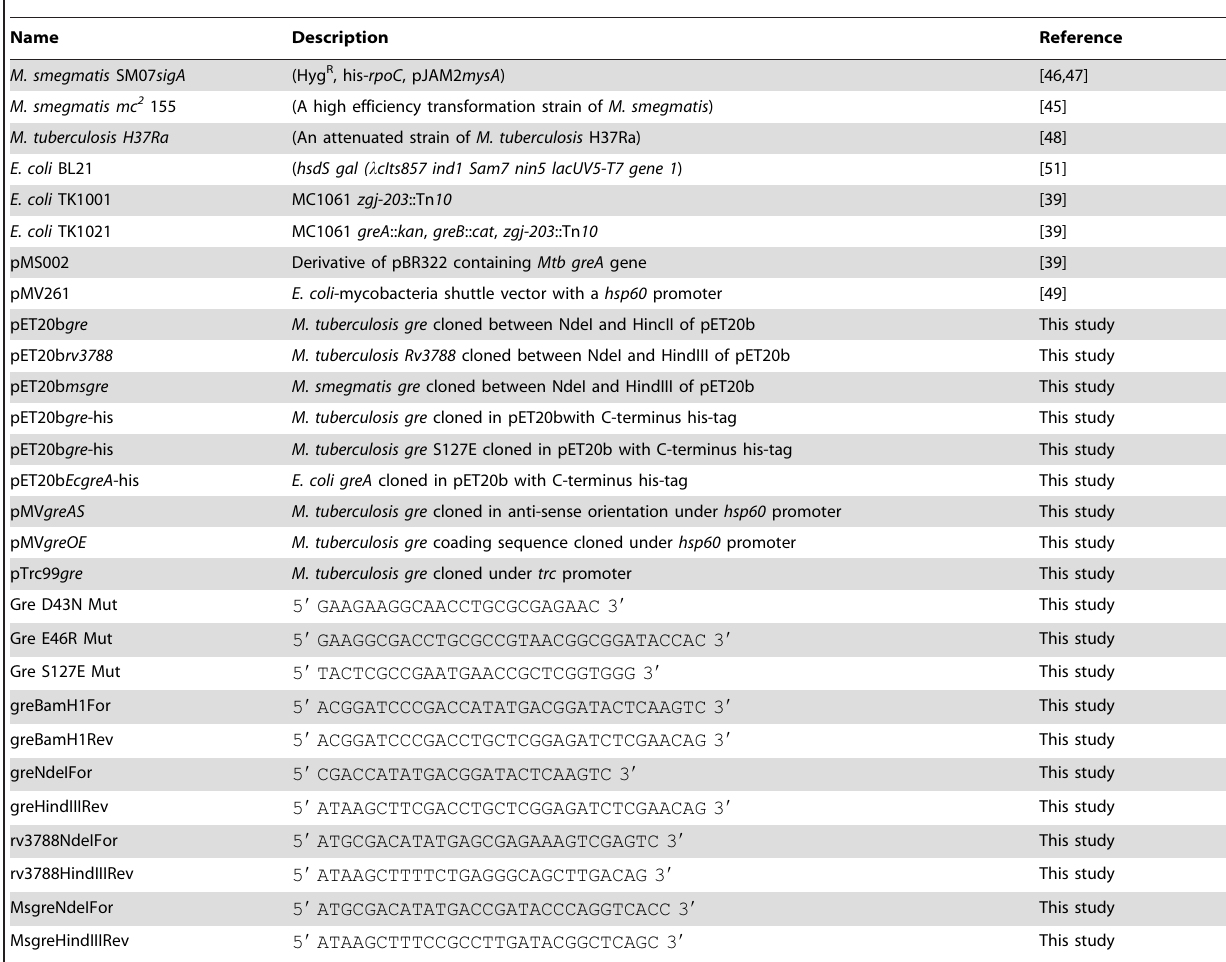
Table 1. Oligonucleotides, strains and plasmids used in this